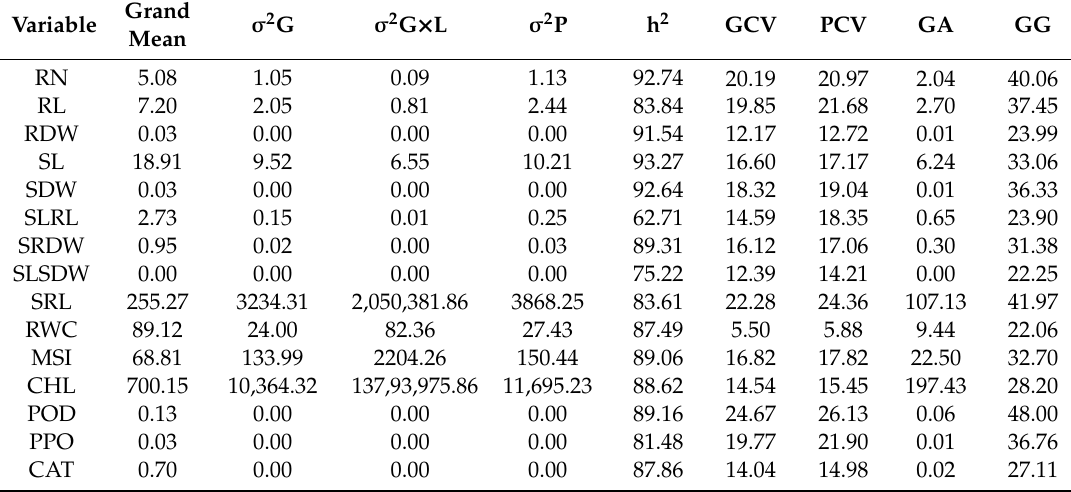
Table 3. Estimates of variance components, heritability, genetic gain, and genetic advance as percent of mean, phenotypic, and genotypic coe ffi cients of variability for 16 genotypes tested at three salinity